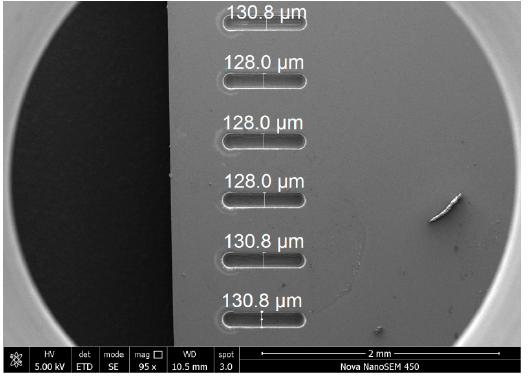
Figure 10. Micro groove array on glass.